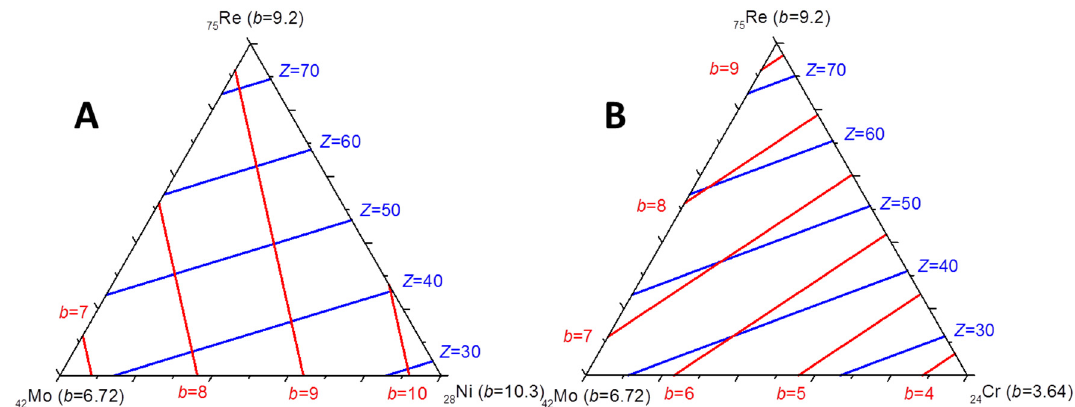
Figure 3. Diagrams showing as parallel lines the compositions of a site occupied by the